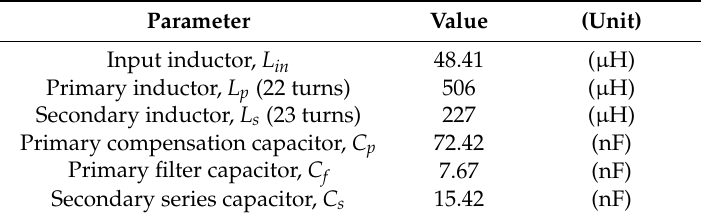
Table 4. Specifications of IPT pads and resonant network.